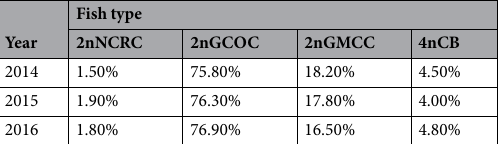
Table 1. Percentage of different types of offspring of 2nCOC ( ♀ ) x 2nBSB ( ♂